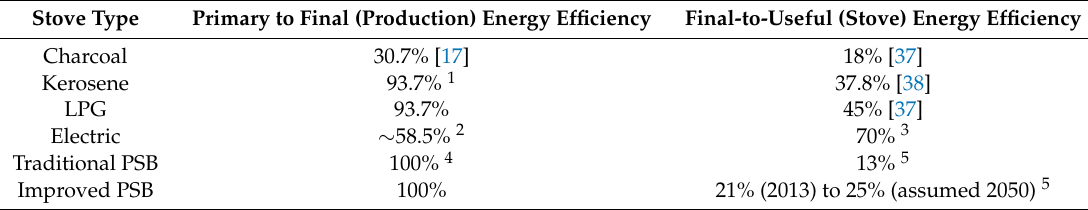
Table 1. Primary-to-Final and Final-to-useful efficiency of traditional and improved PSB, charcoal, kerosene, LPG, and electric